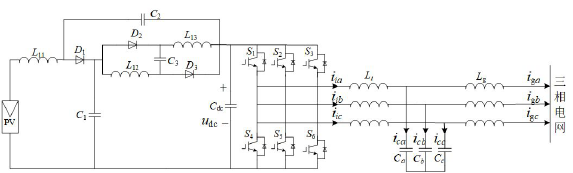
Fig. 1. System structure diagram of quasi-Z-source